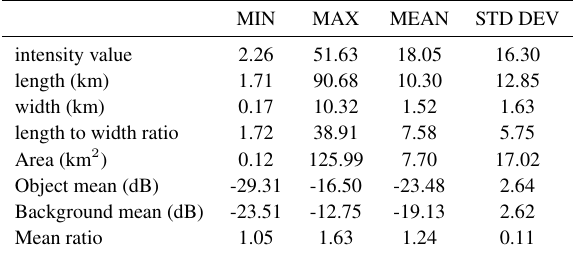
Table 1. Bilge dump features database example.